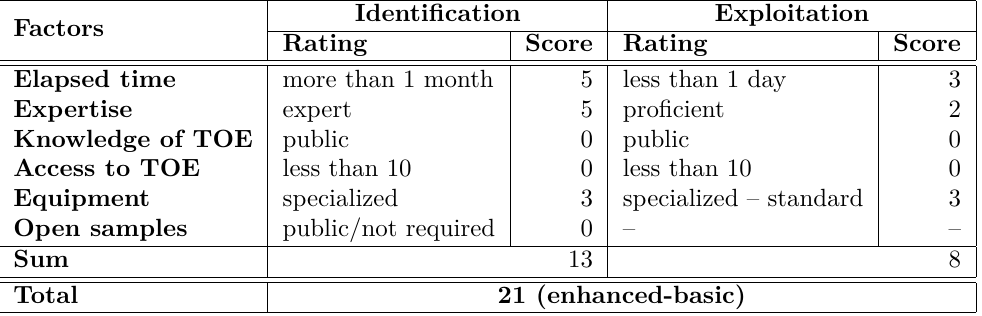
Table 3: Attack rating using an adaptation of the rating for smart cards from Joint Interpretation Library